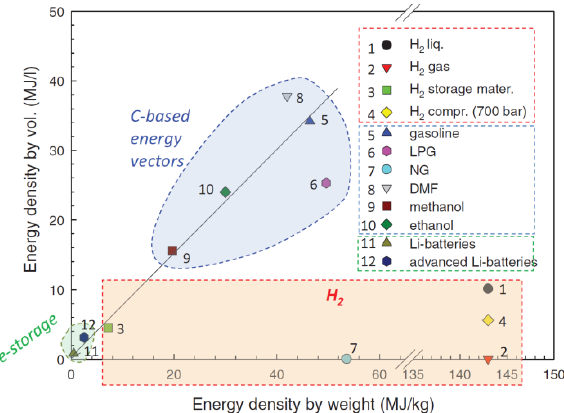
Figure 2. Energy densities by weight and by volume and comparison for different energy carriers.